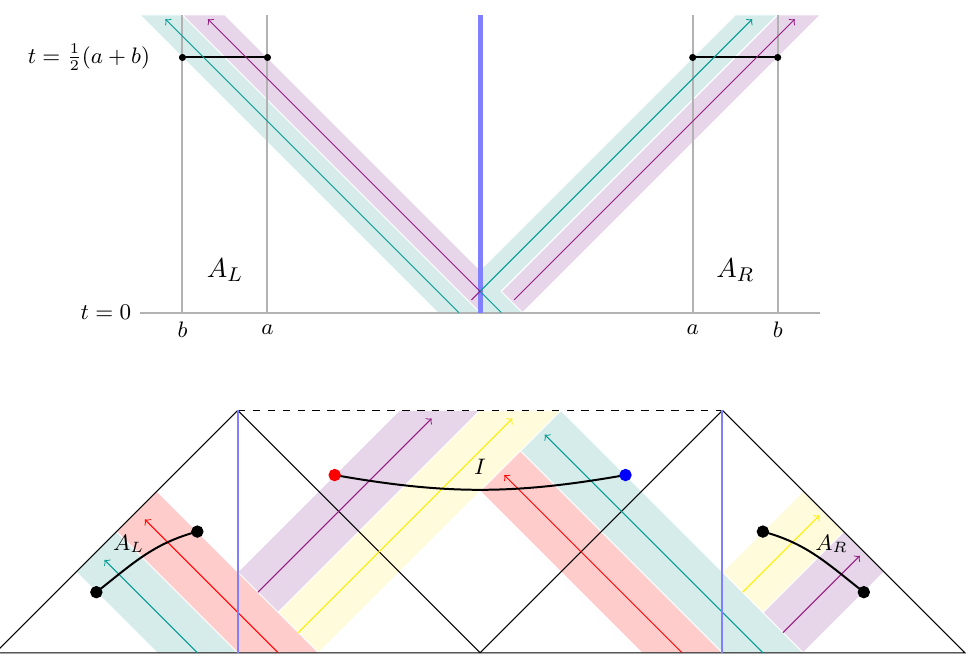
Figure 18 . The explanation for the dip in BCFT (top) and black hole (bottom). The coloured outgoing modes are maximally entangled between left and right and so these modes do not con- tribute to S ( A L ∪ A R ) . It follows that the entropy is only one half of the thermodynamic entropy of the two intervals. Note that in the BCFT case, the green (purple) modes on the right (left) side start as left- (right-)moving modes at t = 0 that reflect off the boundary whereas in the black hole there are four distinct sets of